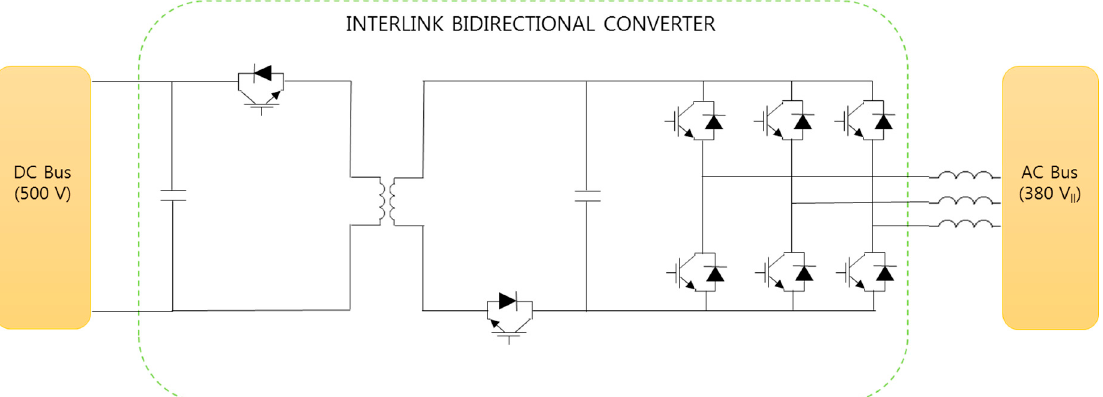
Figure 2. IC configuration.